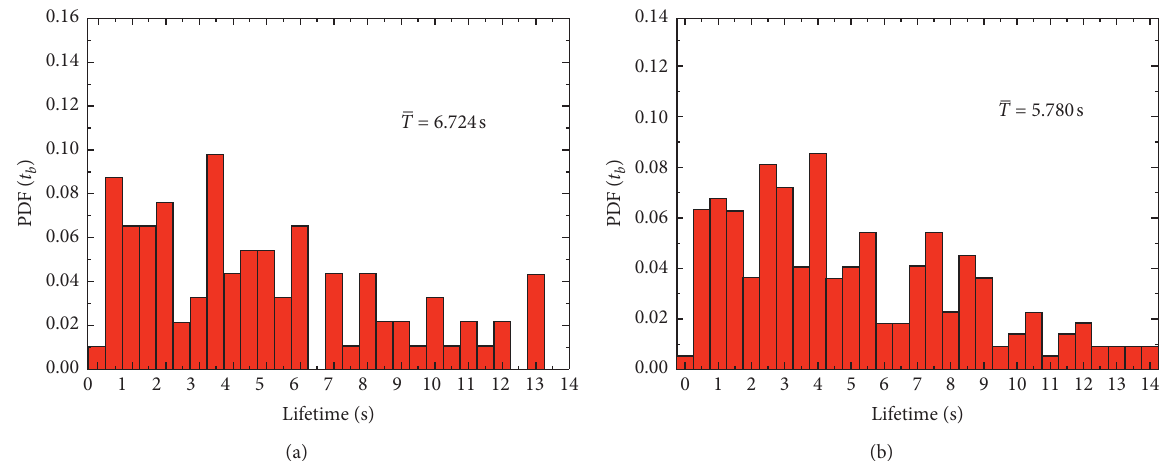
Figure 8: Bubble lifetime distribution histogram at a liquid temperature of 47.5 ° C and an air temperature of 23.9 ° C: (a) cap diameter � 9.4–10.2mm and (b) cap diameter � 12.4–13.2